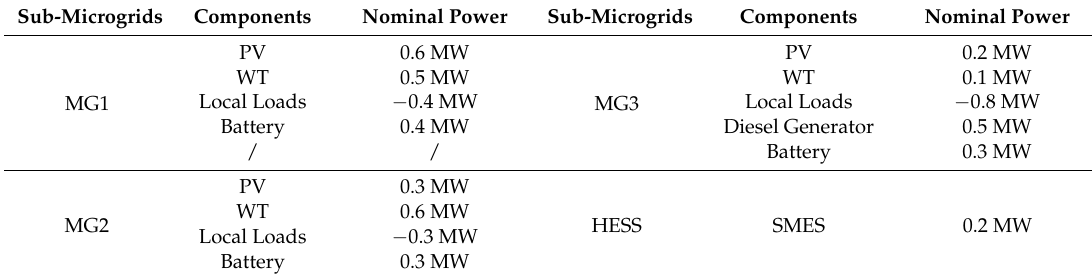
Table 2. Components of the sub-microgrids and their nominal active